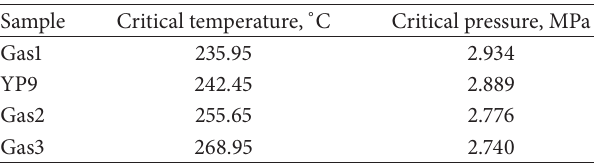
Table 7: The critical parameters (critical temperature and critical pressure) of C 6